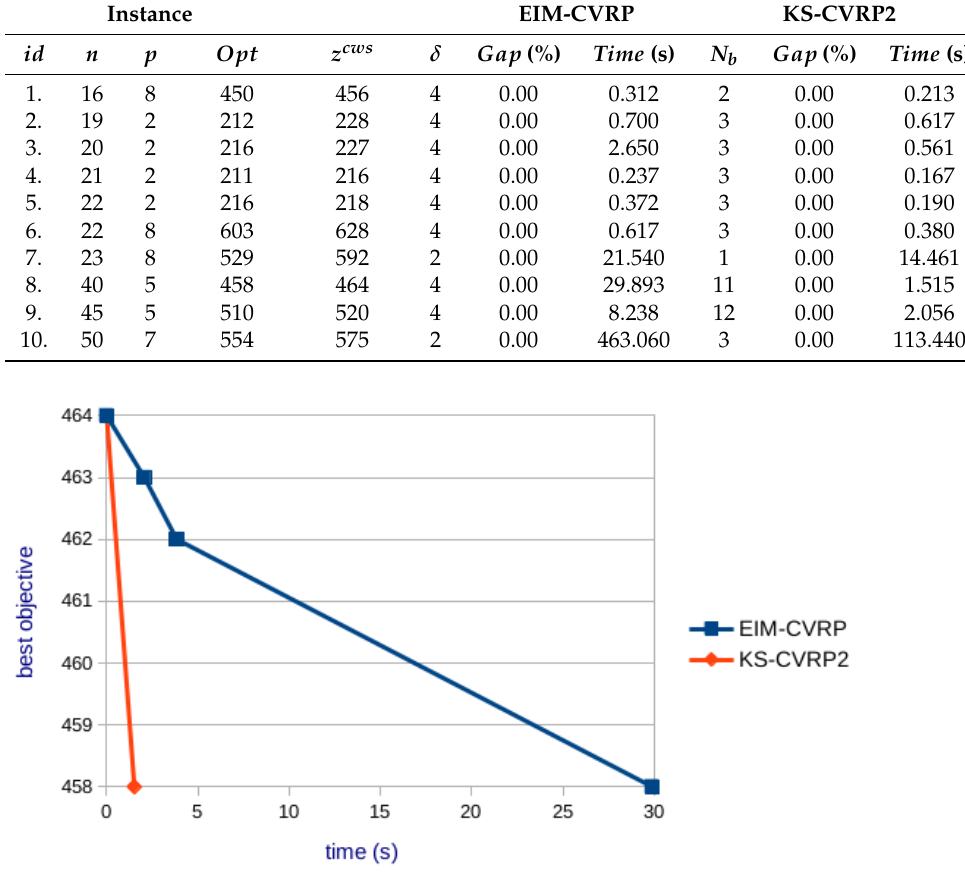
Table 3. Comparison of the KS-CVRP2 and the EIM-CVRP.